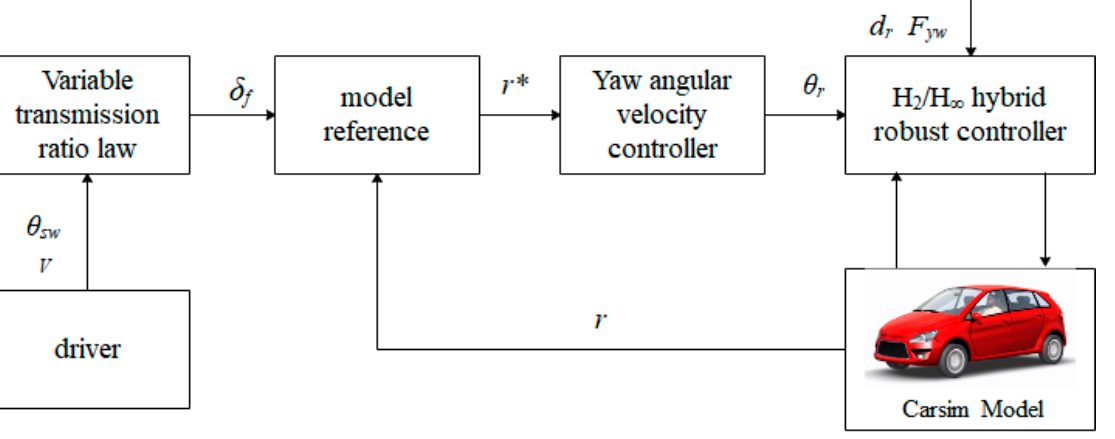
Figure 3. Overall control strategy logic diagram.